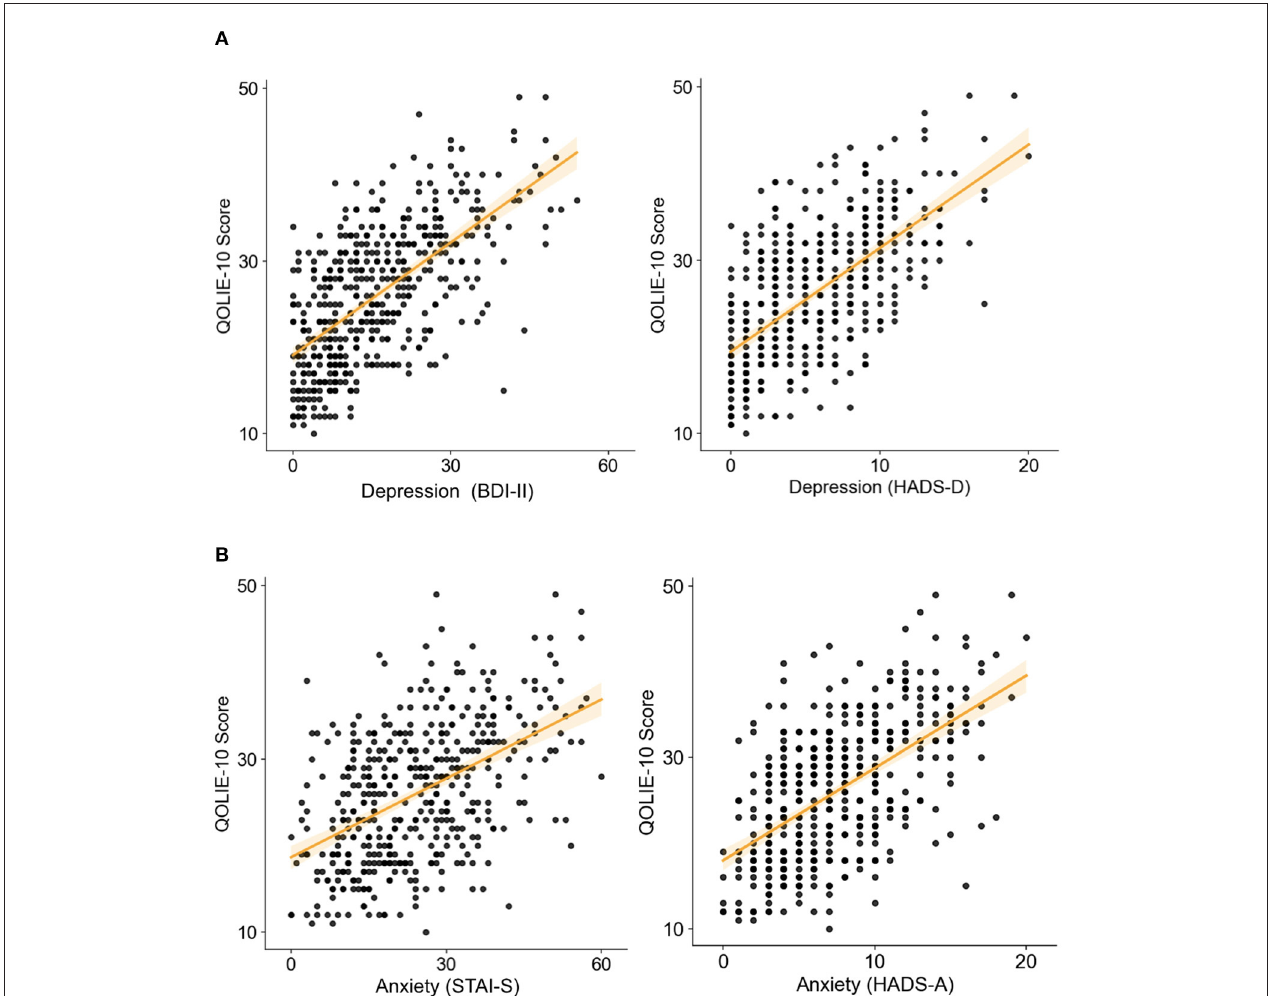
FIGURE 3 | Inferior health-related quality of life is significantly associated with increased symptoms of depression and anxiety (higher score means lower perceived quality of life). Correlation between Quality of Life in Epilepsy Inventory-10 (QOLIE-10) overall score and scores of (A left) Beck Depression Inventory-II (BDI-II), (A right) Hospital-Anxiety and Depression-Scale (HADS) depression subscale, (B left) State-Trait-Anxiety-Inventory (STAI), and (B right) HADS anxiety subscale (all with p < 0.001).